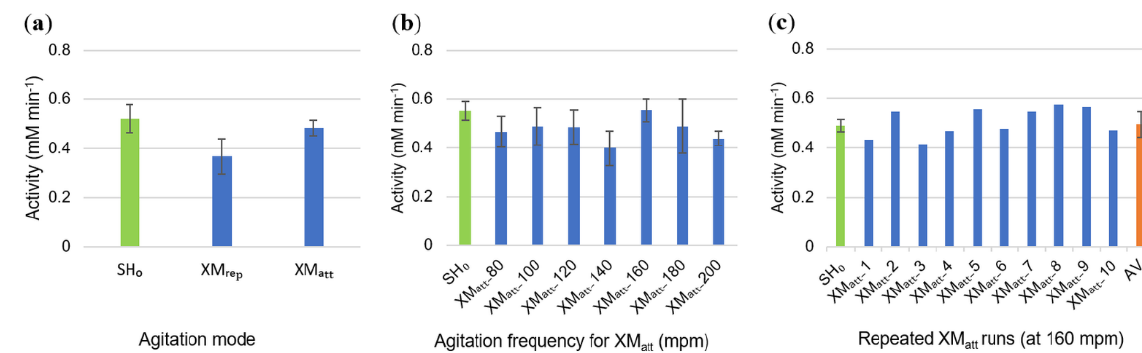
Figure 4. Investigation of the axial agitation mode with AAL-MNPs. ( a ) Dependence of the effective enzyme activity on permanent magnet configuration (XM att : attraction configuration, XM rep : repulsion configuration; at 120 MPM) compared to shaking mode with fresh AAL-MNPs (SH 0 ). ( b ) Dependence of the effective enzyme activity on the frequency of movement along the x -axis ((using the XM att mode, in movement per minute (mpm), within the 80–200 mpm range). ( c ) Investigation of operational stability (repeatability) of the AAL-MNP reaction by XM rep mode at 160 mpm (the biocatalyst was used 10 times after recovery by magnetic decantation). The results and their average (AV) are compared to shaking mode with fresh AAL-MNPs (SH 0 ).